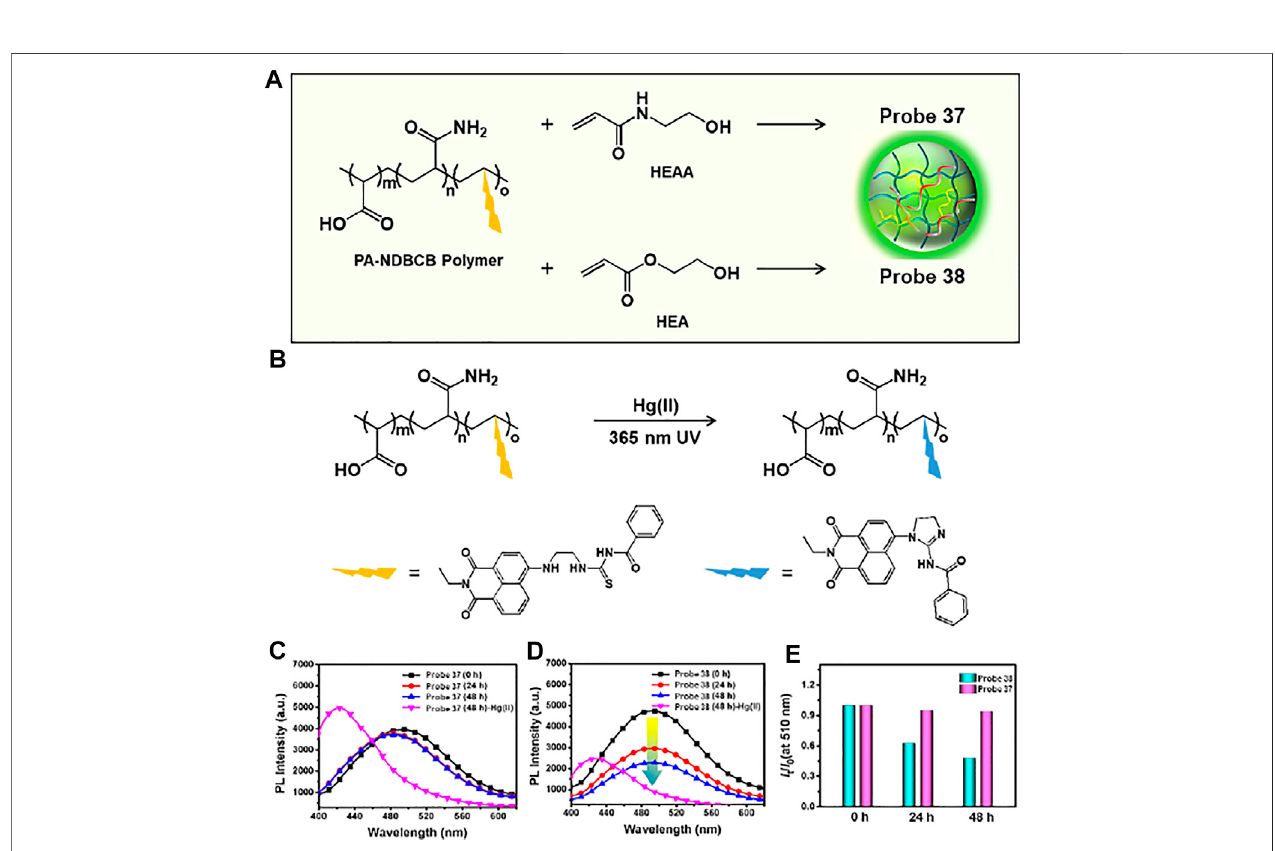
FIGURE 19 | (A) Hydrogel components of probes 37 and 38. (B) The sensing mechanism of the probes to Hg (II) ion. (C , D) Time-dependent change of fl uorescence spectra between probes 37 and 38 for E. coli coculture. (E) Emission intensity ratio I with permission from Zhang et al. (2019). Copyright © 2019, American Chemical